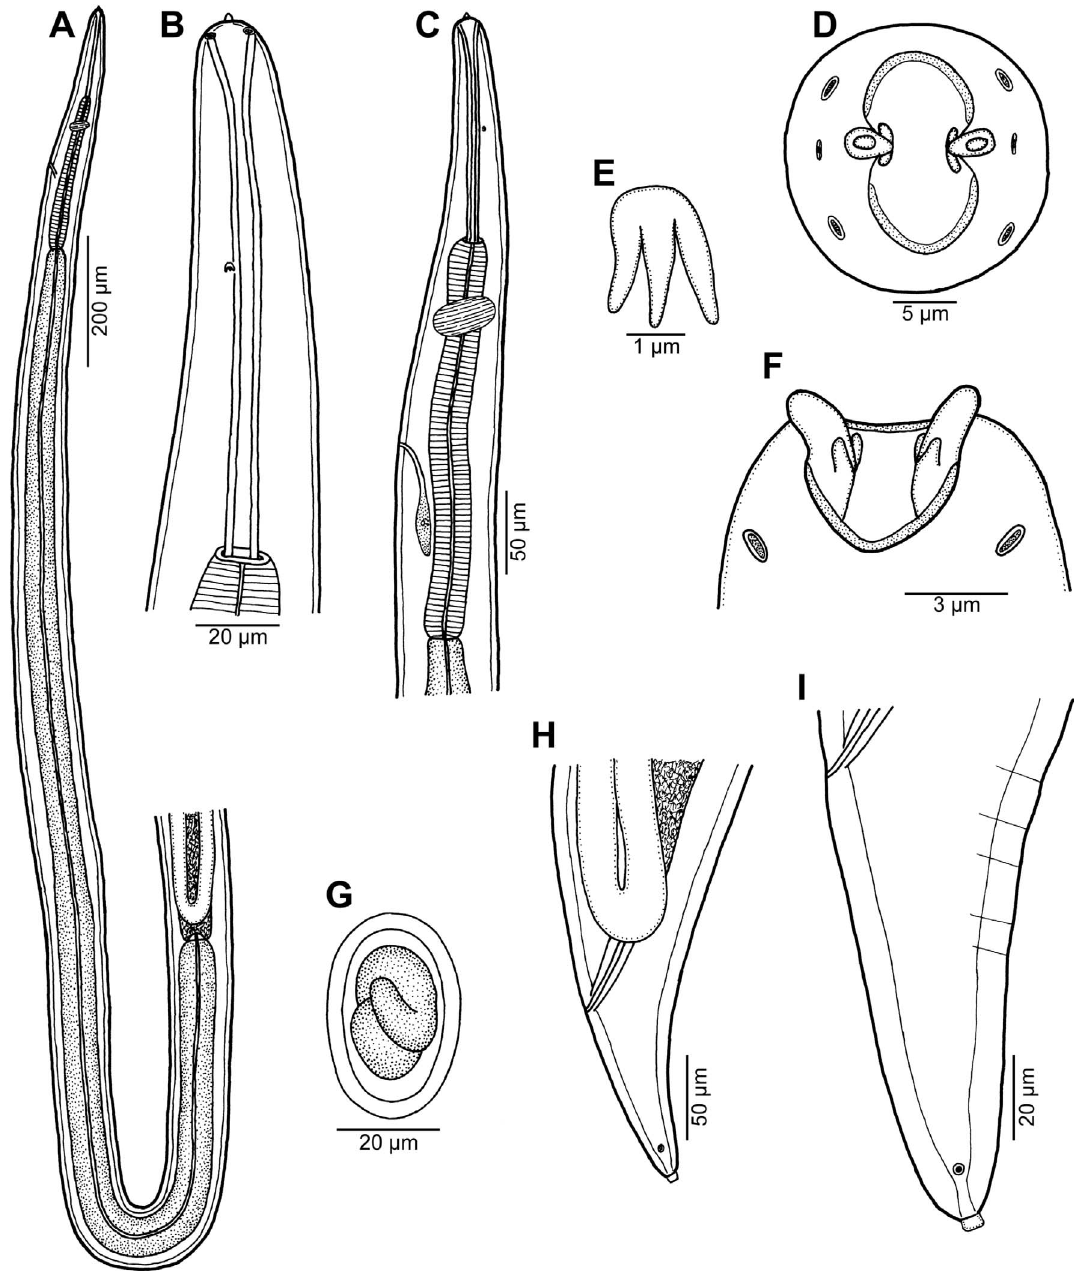
Figure 7. Ascarophisnema tridentatum Moravec et Justine, 2010 from Gymnocranius grandoculis ,